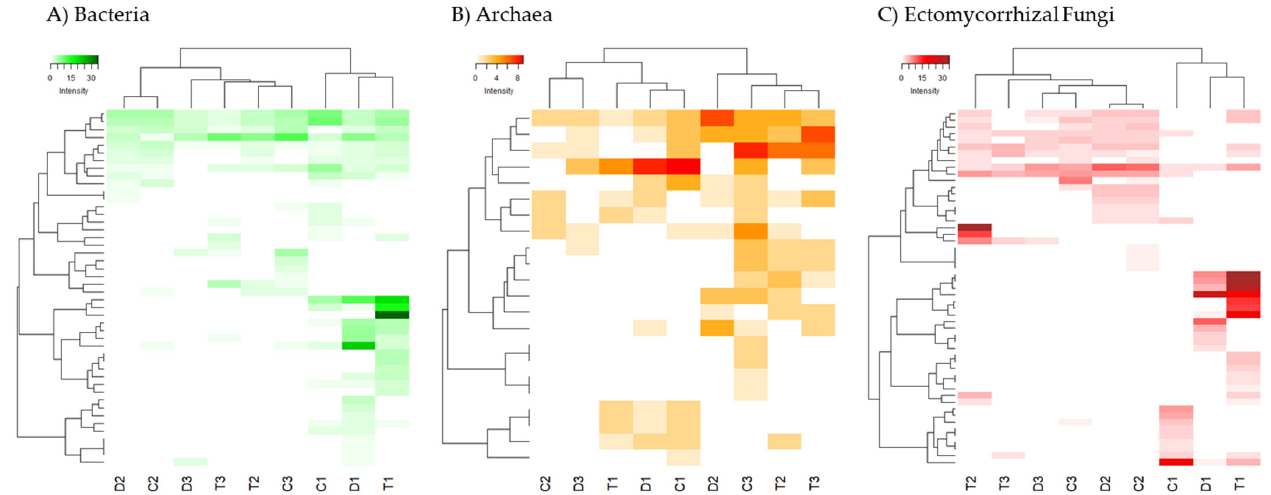
Figure 2. Heatmap of two-way cluster analysis performed on the fingerprinting profiles of the DGGE analysis for ( A ) Bacteria. ( B ) Archaea and ( C ) ectomycorrhizal Fungi. Both fingerprinting profiles and samples were clustered using Bray- Curtis dissimilarities. The colour intensity in the cluster dendrogram corresponds to the abundance of normalized inten- sity of the DGGE